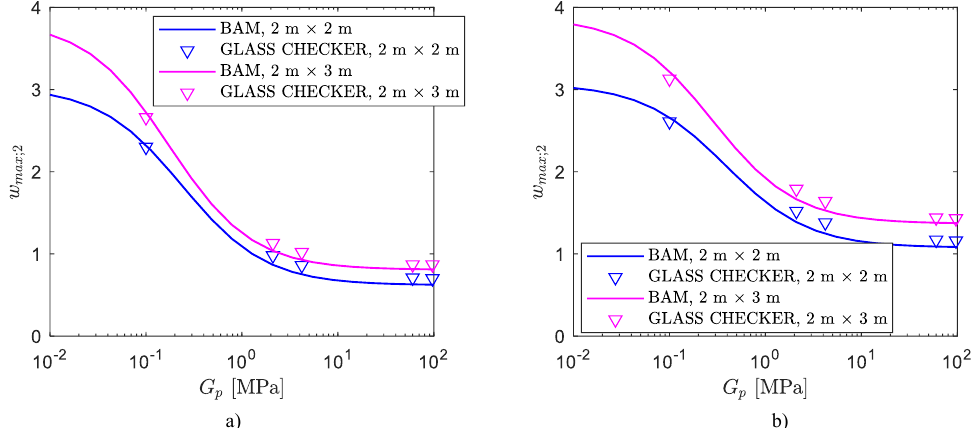
Fig. 15 Rectangular DGUs under concentrated load. Maximum deflection of plate 2 for DGUs under a) Case A (laminated + laminated) and b) Case B (laminated + monolithic). Comparisons between BAM approach (continuous line) and Glass Checker